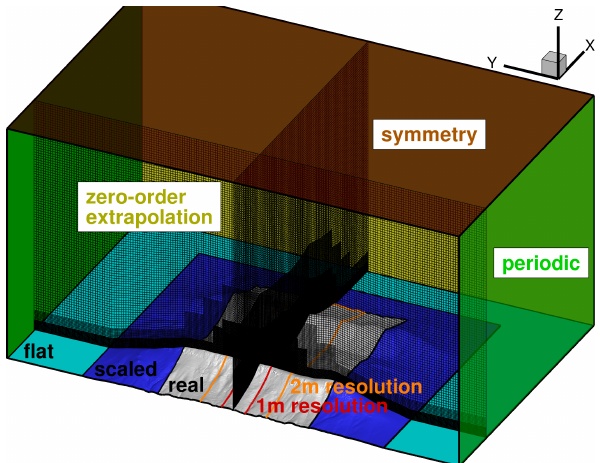
Figure 2. CFD domain for the FLOWer simulation of the complex terrain in Perdigão with boundary conditions and terrain mesh for a wind direction of 230 ◦